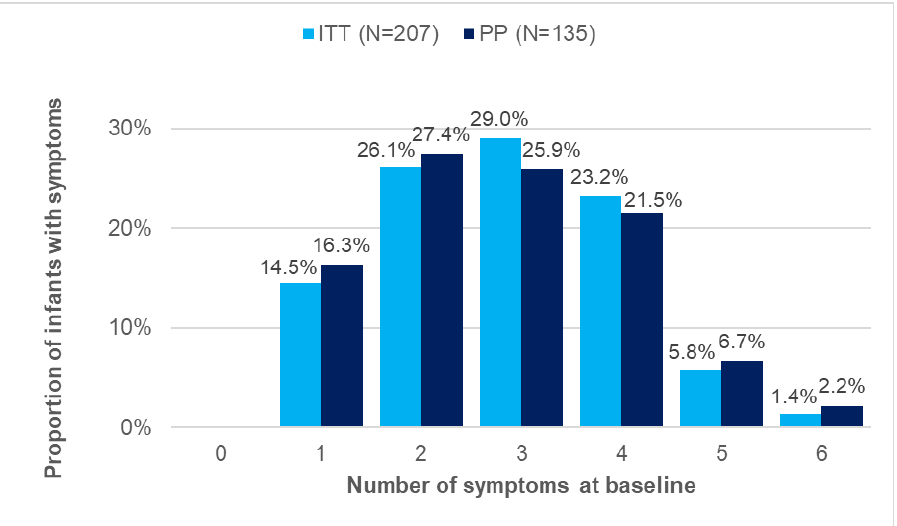
Figure 2. Breakdown of infants according to the number of symptoms at baseline in the ITT population ( n = 207) and in the PP population ( n = 135).